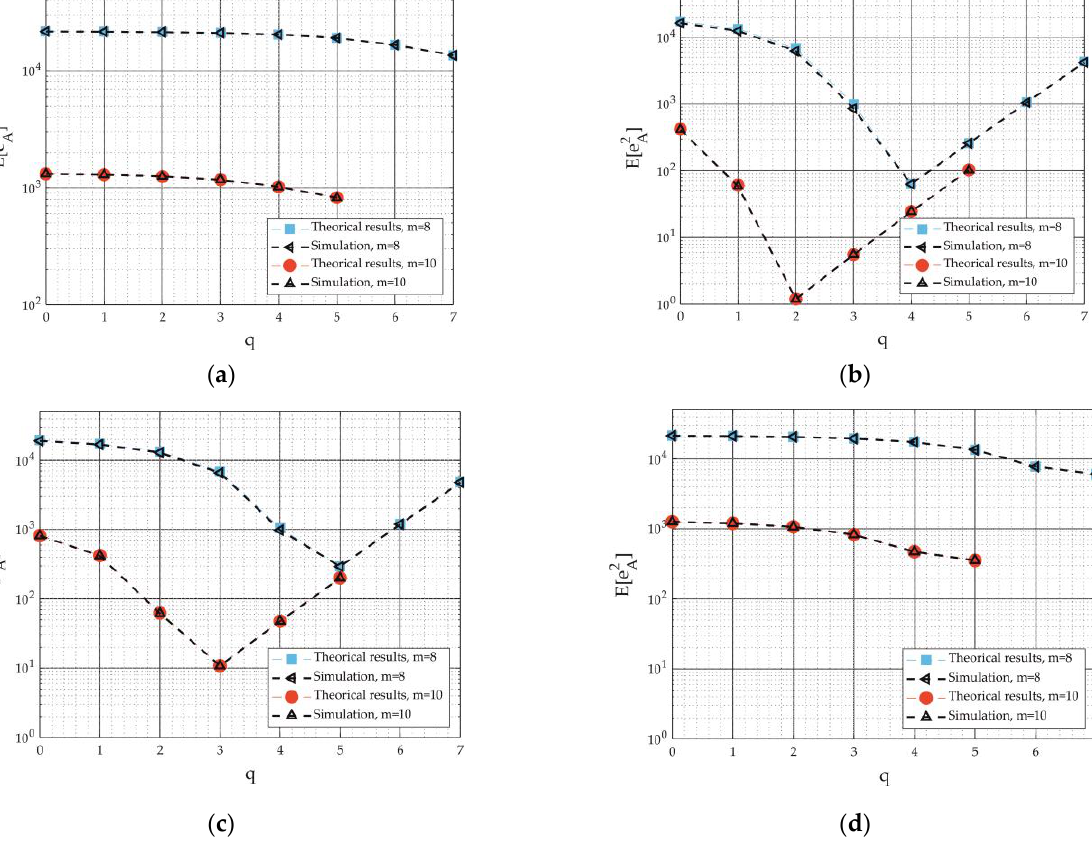
Figure 5. Mean square error on the input signal A as a function of m and q with ( a ) uniform distribution and half-normal distribution in the cases of ( b ) σ = 1024, ( c ) σ = 2048, and ( d ) σ = 16,384. In this example, A is an integer signal expressed on n = 16 bits.